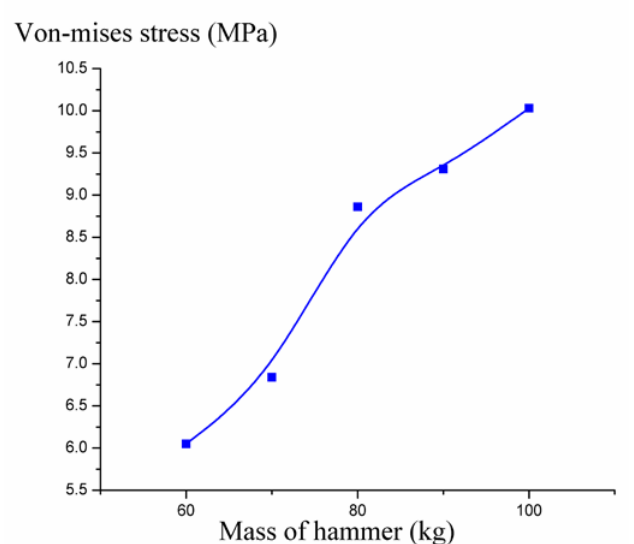
Figure 5: Effect of anvil mass on the Von-Mises stress of hydraulic hammer with horizontal oriented sliders. Meanwhile, the variation of anvil mass on the abrasion property of hydraulic hammer with horizontal oriented sliders